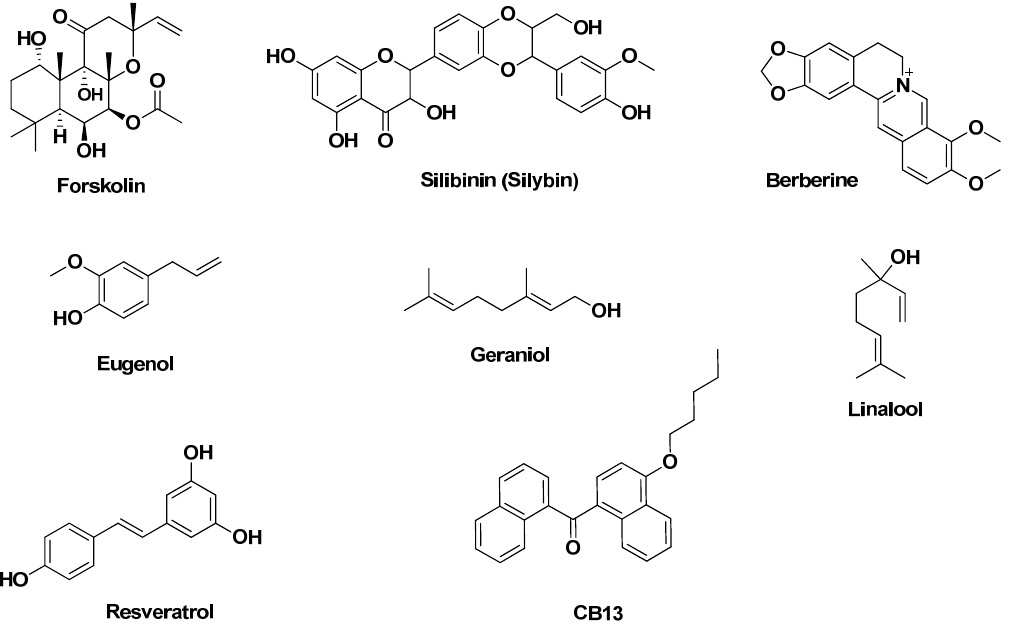
Figure 6. Chemical structures of natural products belonging in various structural families encapsulated in chitosan or modified chitosan nanoparticles